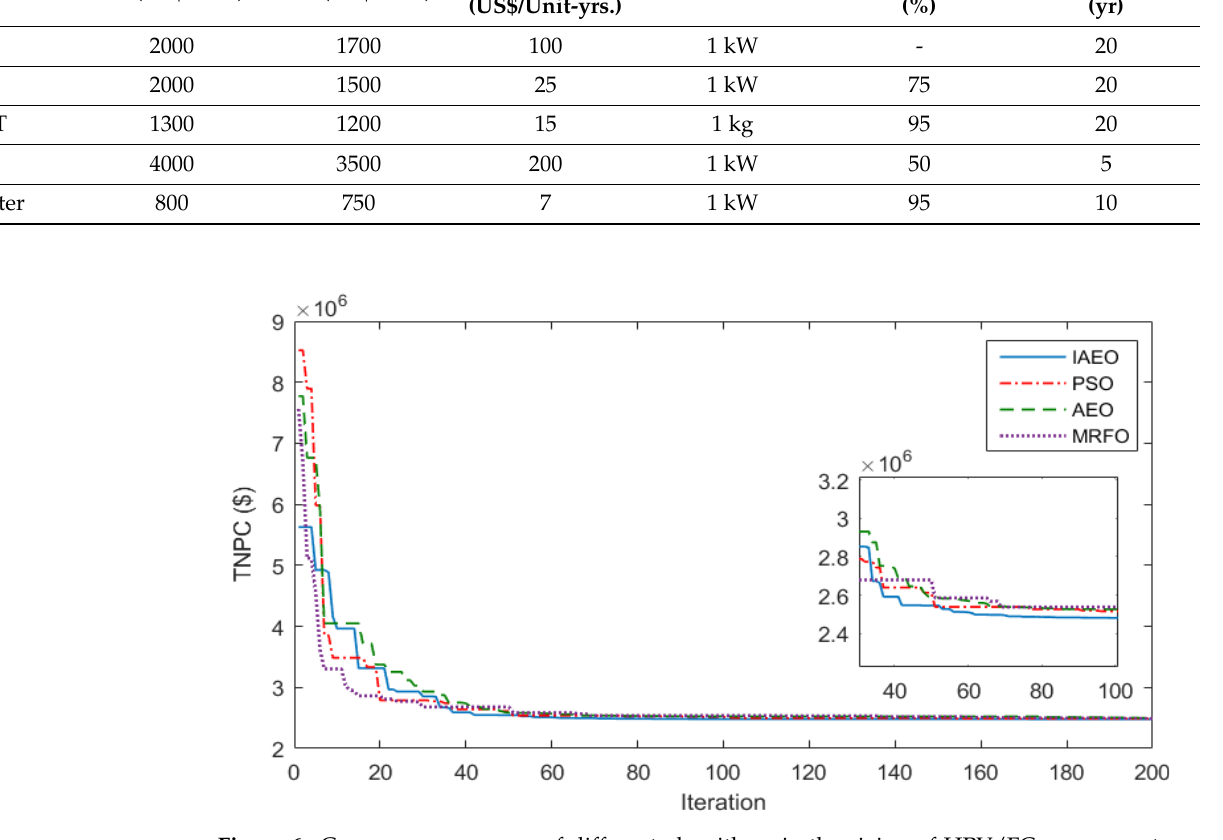
Figure 6. Convergence process of different algorithms in the sizing of HPV/FC energy systems considering ENSP max = 1%. Table 2. Sizing results of the HPV/FC energy system considering ENSP max = 1%.